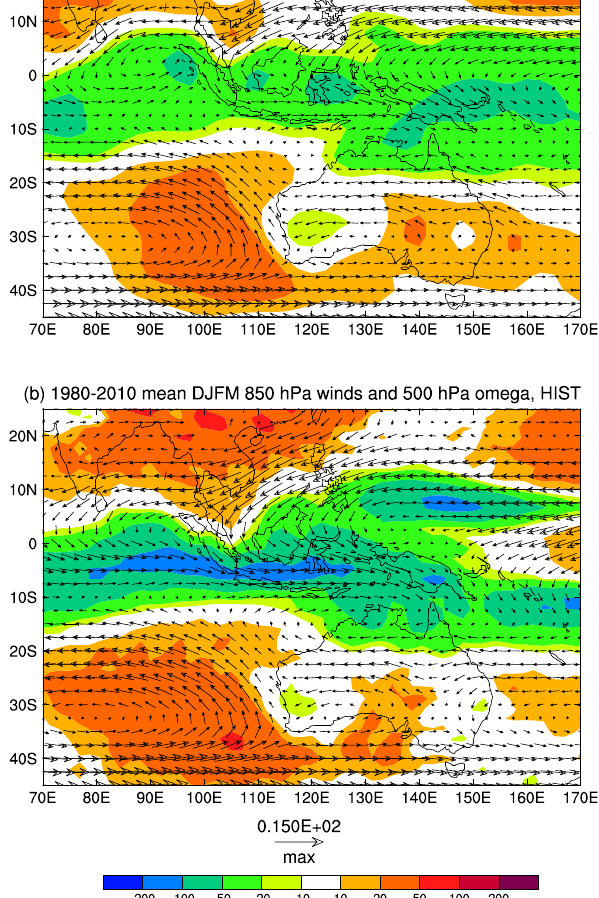
Fig. 6. Simulated mean 850hPa wind vectors (ms − 1 ) and 500hPa vertical velocity (shading, hPaday − 1 ) for DJFM, averaged over 1980 to 2010, (a) from the HIST ensemble, and (b) from NCEP- DOE Reanalysis 2. The maximum vector is shown below the plot.